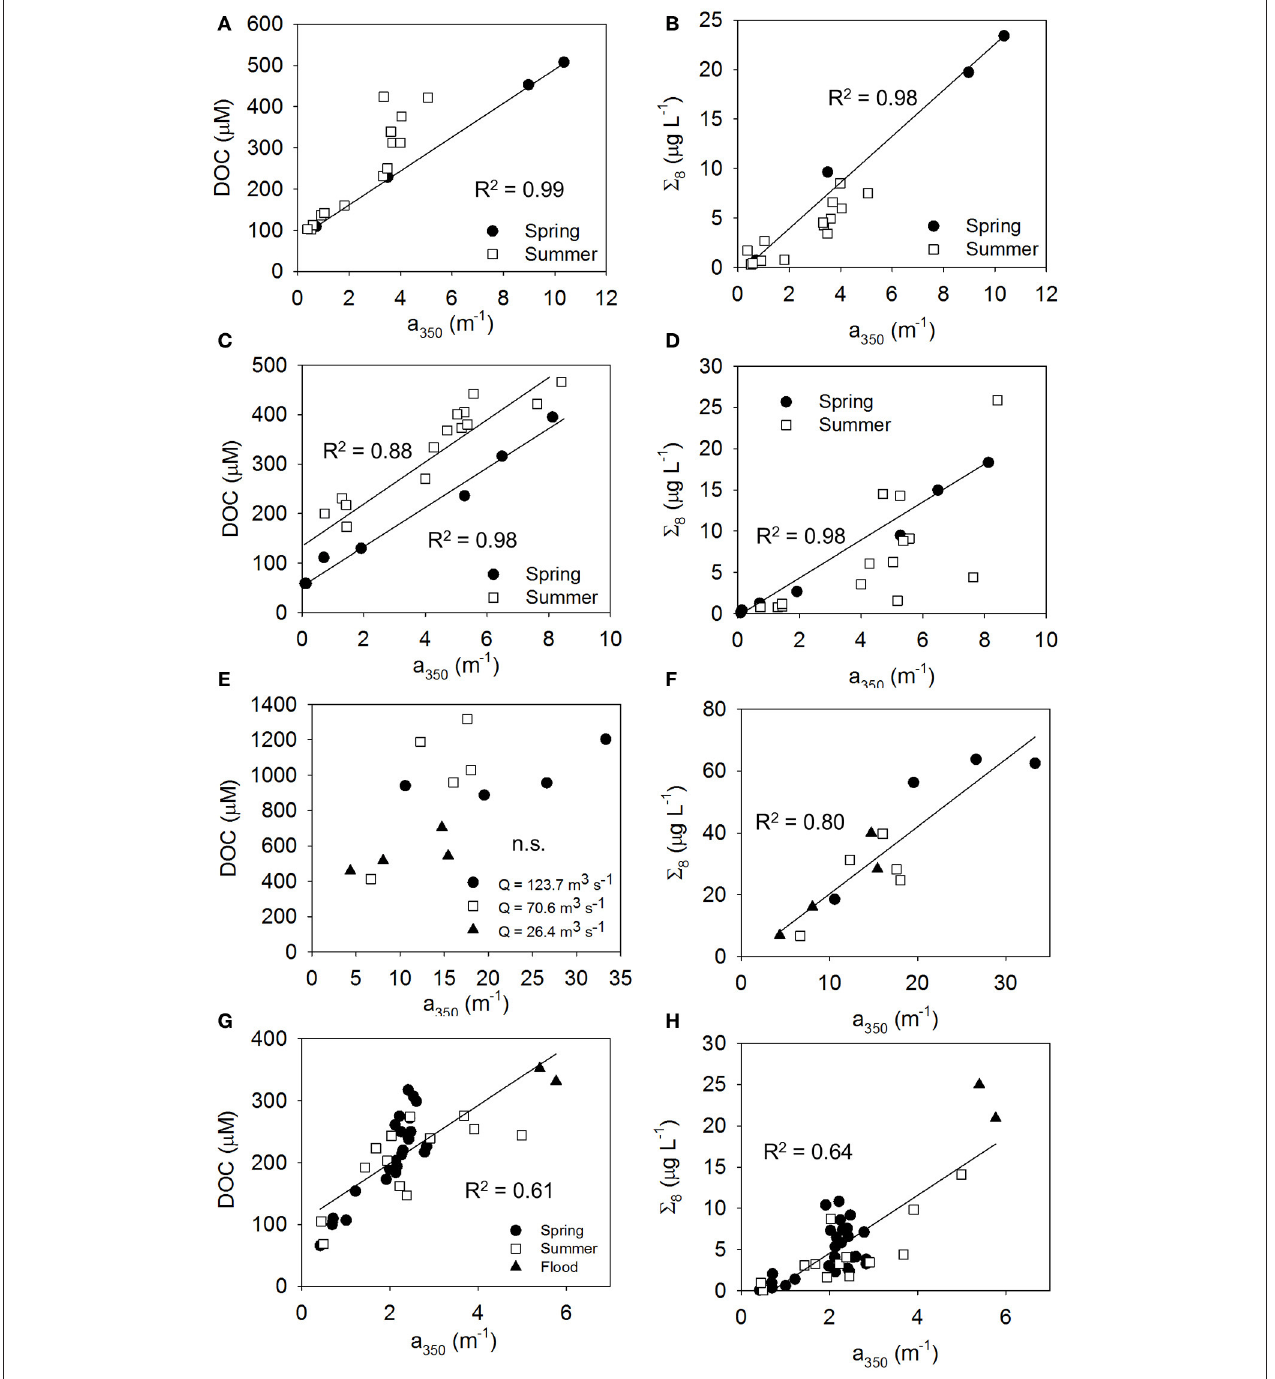
FIGURE 8 | Relationships between CDOM and DOC (left column of panels A, C, E, and G) and lignin (right column of panels B, D, F, and H) linking the optics and chemistry of DOM, influenced by hydrologic variability. (A,B) MRE showing influence of spring freshet, (C,D) ARE showing influence of 2011 Mississippi River flood, (E,F) NRE showing seasonal influence of river discharge, and (G,H) CBE showing the influence of heavy rains in summer 2006. Significant linear regressions are shown while slope and intercept values and regression statistics are in Table 3 . For (F–H) , the regressions were fit to all of the data.